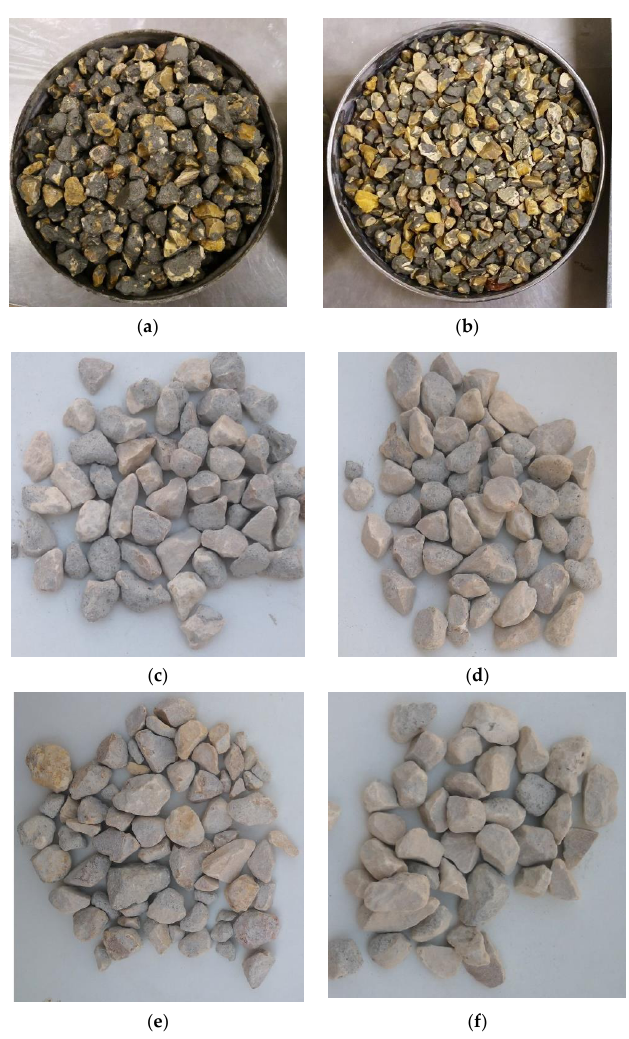
Figure 5. Treatment of RCA using LA abrasion: ( a ) Untreated RCA; ( b ) Treated RCA; ( c ) close-up of treated RCA with D46-T5; ( d ) zoomed view of treated RCA with D46-T10; ( e ) zoomed view of treated RCA with D60-T10; and ( f ) zoomed view of treated RCA with D46-T15 (Legends Dp: p mm dia balls, Tq: q minutes of LA abrasion duration).